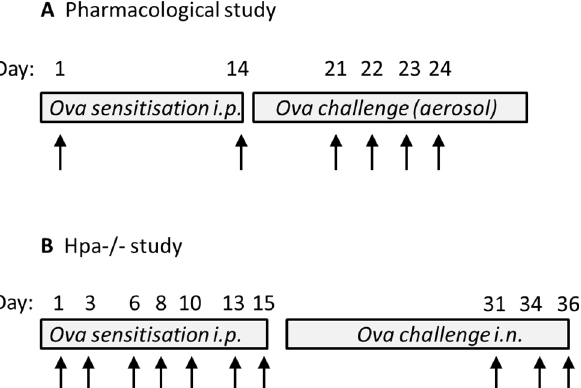
Fig 1. Protocol for allergen sensitization and challenge. Diagrammatic representation of the sensitization and challenge protocols to induce allergic lung inflammation in WT BALBc (A) and Hpa -/- (B) mice. Arrow represents exposure to ovalbumin (OVA). Biological readouts were undertaken 24 h following the last OVA administration. In (A), bronchoalveolar lavage and lung function was measured on day 24 and day 25 respectively. In (B), BAL and serum samples were collected on day